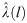
Statistical mechanical basis of the information thermodynamic model.(A) Analysis based on Weibull distribution. (B) Analysis based on GG distribution. Under Landauer’s principle statistical mechanical probability distributions were derived for the absolute amount of information IR processed by the methylation machinery in a genomic region R (Eqs 12 and 14, Material and Methods). For each partition of the methylome into genomic regions, nonlinear fits were performed to estimate the scaling parameter λ^(l). Next, regression functions were obtained from the regression analyses λ^¯(l) versus l, as predicted by Eq 18 (19). The estimations of the DNA persistence length L^p were based on Eq 20.